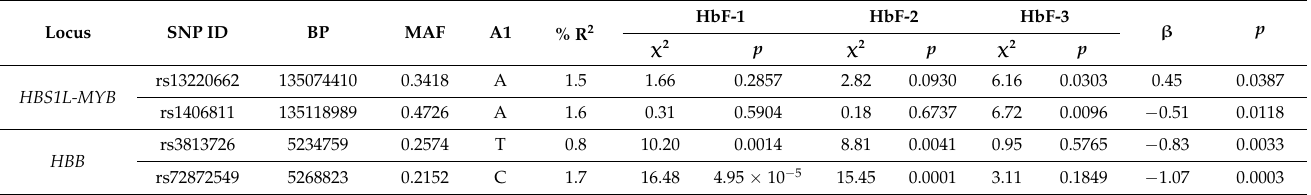
A1 indicates Minor Allele; β , Beta Coefficient; BCL11A , B-cell lymphoma/leukemia 11A; BP, Physical Position; HBB , beta globin; HBS1L- MYB , intergenic region between GTP-binding elongation factor HBS1L and myeloblastosis oncogene MYB; ID, Identification; MAF, Minor Allele Frequency; % R 2 , Variance Explained; χ 2 ,